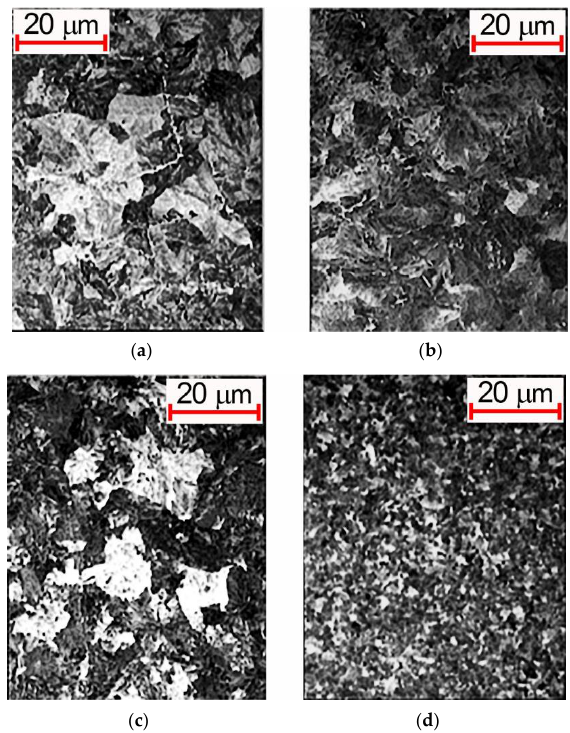
Figure 6. Microstructure of the rail head metal (E76HGF) welded by pulsating melting where ( a ) welded joint; ( b ) partial melting zone; ( c ) zone of the eutectoid mixture of pearlite and cementite after overheating; ( d ) zone of the eutectoid mixture of pearlite and cementite without overheating. In the zone of incomplete melting, the structure of the metal is similar to the structure of the weld, and the ferrite network is present in the form of separate fragments (Figures 5b and 6b). Accumulations of non-metallic inclusions along the boundaries of grains and looseness are possible with insufficient sediments during metal deformation. Therefore,